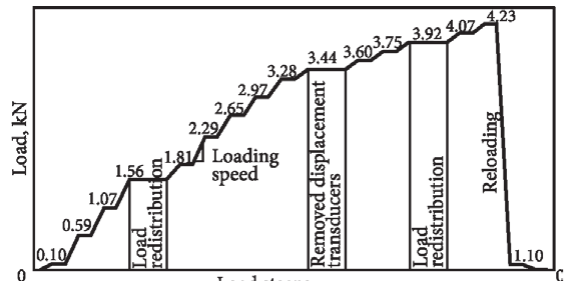
Fig. 3. Loading history of the symmetric load